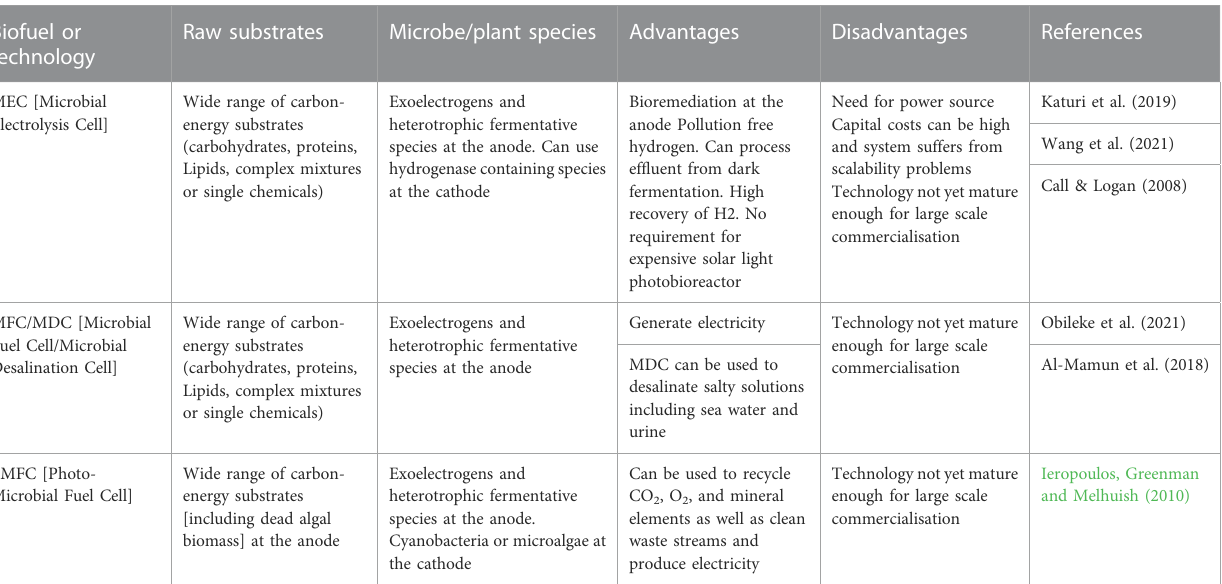
TABLE 4 ( Continued ) Comparison between different types of biofuel and